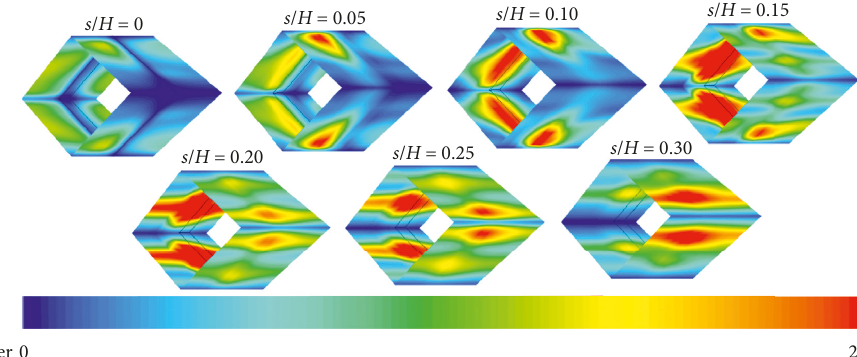
Figure 12: Nu x of the heat exchanger square duct installed with the 45